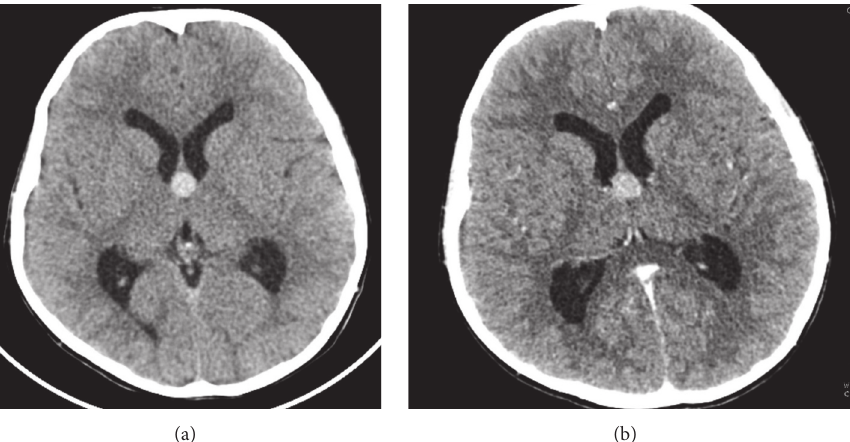
Figure 1: (a) Nonenhanced axial section at the level of the foramen of Monro: a well-defined, round, hyperdense lesion causing mild prominence of bilateral lateral ventricles. (b) Contrast enhanced image shows no significant enhancement in the lesion.